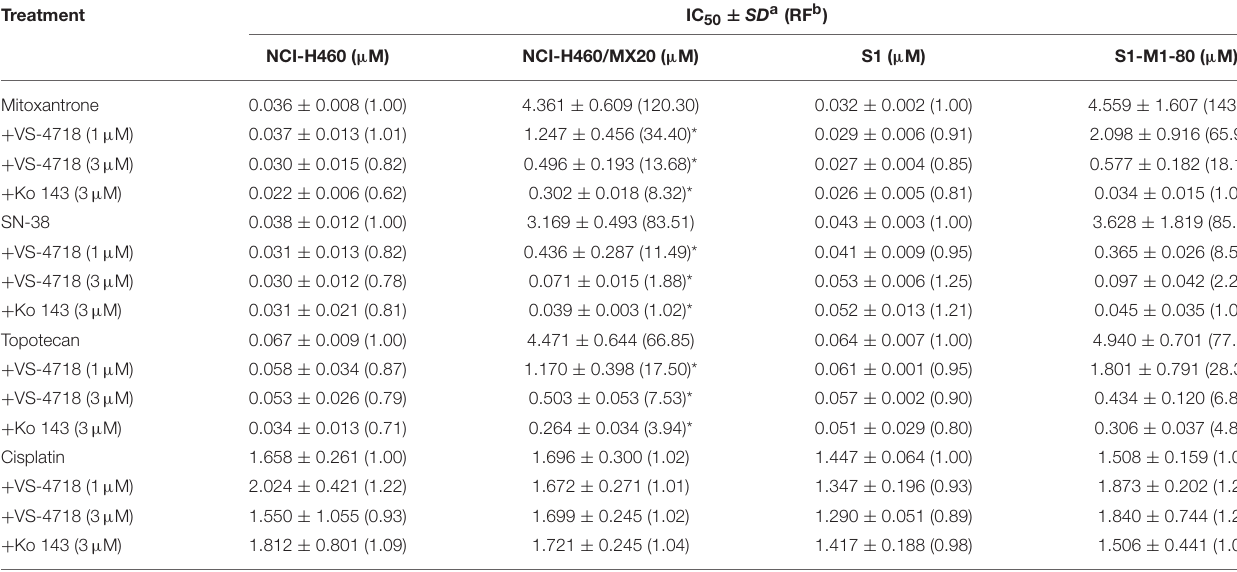
TABLE 3 | VS-4718 sensitized ABCG2-substrate-selected resistant cells to ABCG2 substrates.